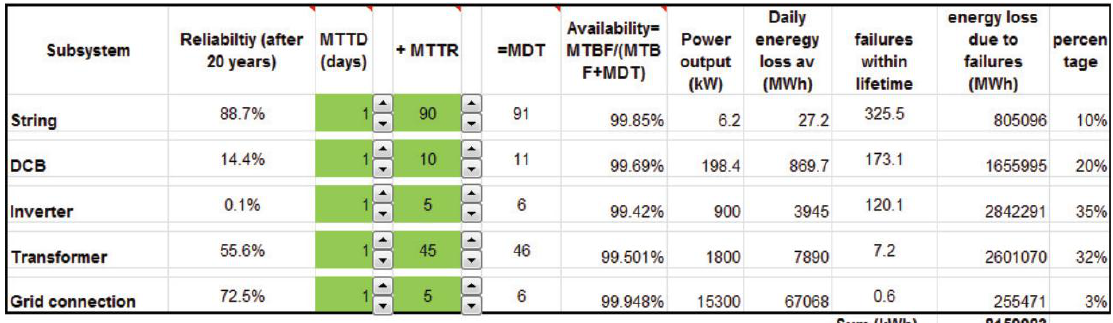
Figure 7 . Energy loss calculation model with input MTTD and MTTR (green highlighted) parameters for the subsystems.